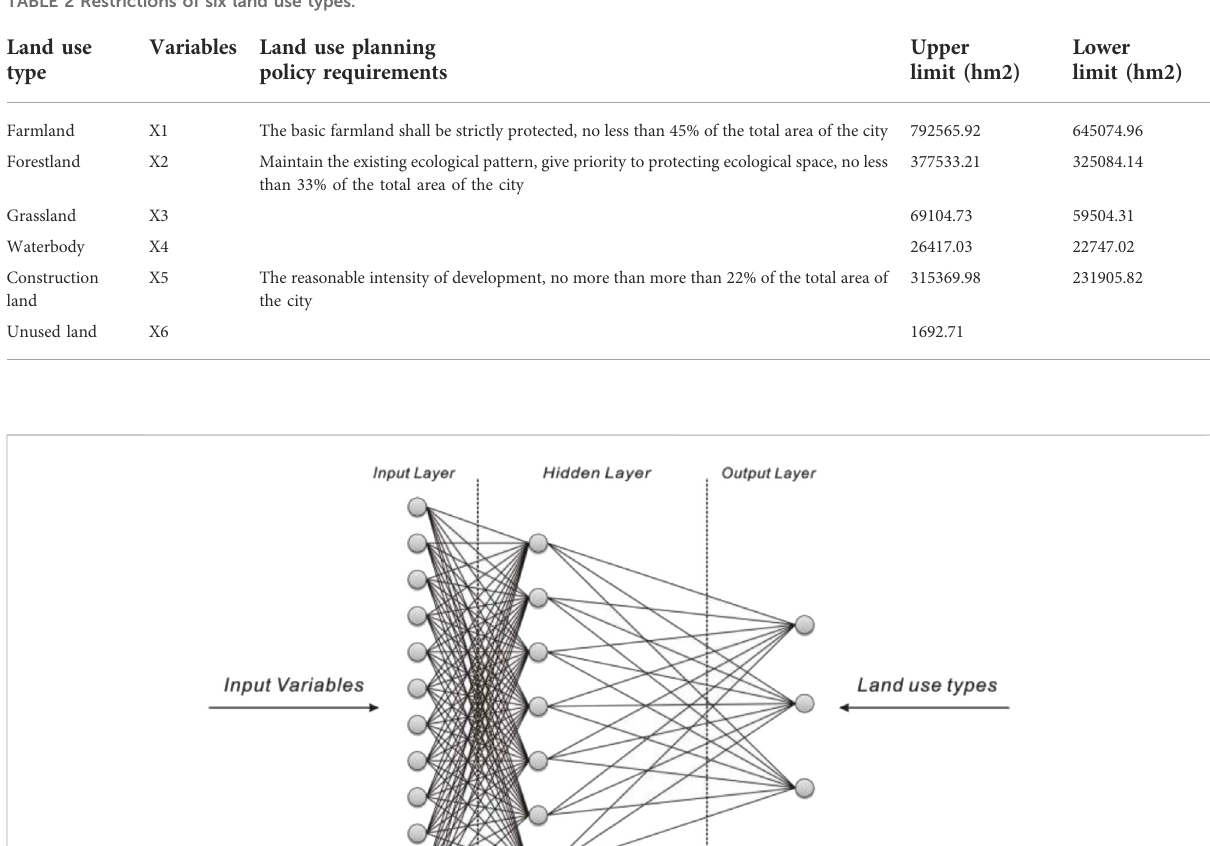
TABLE 2 Restrictions of six land use types.